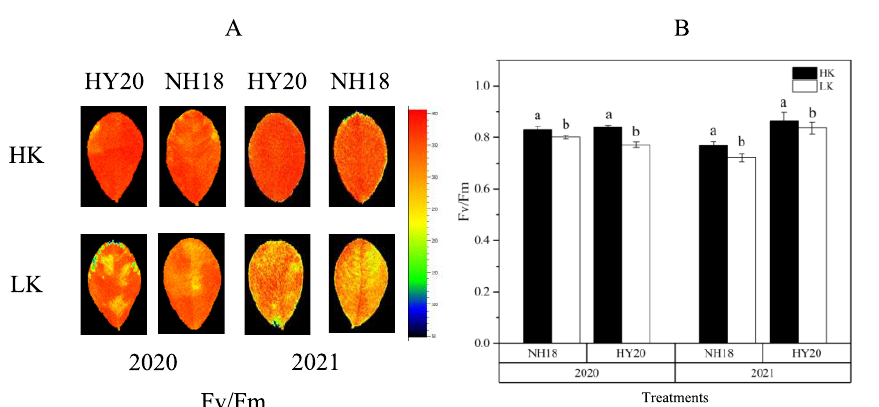
Figure 8. Chlorophyll fluorescence imaging under low K stress. Chlorophyll fluorescence imaging under low K stress-Fv/Fm ( A ); Effect of low K stress on fluorescence parameter Fv/Fm ( B ). HK: high K treatment; LK: low K treatment. For the bar chart, a,b indicates a significant difference between different treatments for the same variety ( p < 0.05).